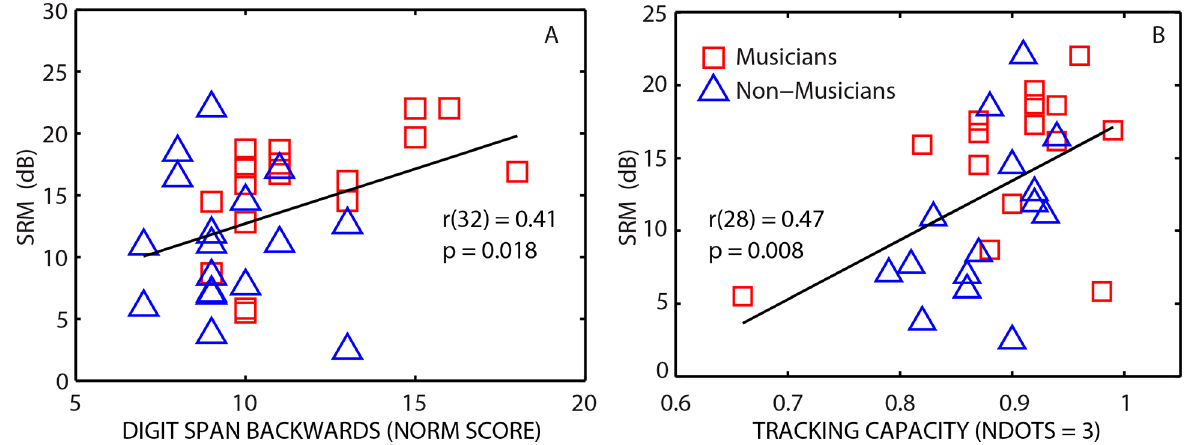
Fig 4. Panel A: Scatter plot shows spatial release from masking (SRM = colocated — separated thresholds) plotted against digit span backwards score for individual subjects. Panel B: Scatter plot shows SRM plotted against tracking capacity for ndots = 3. Solid line shows least-squares fit to the data